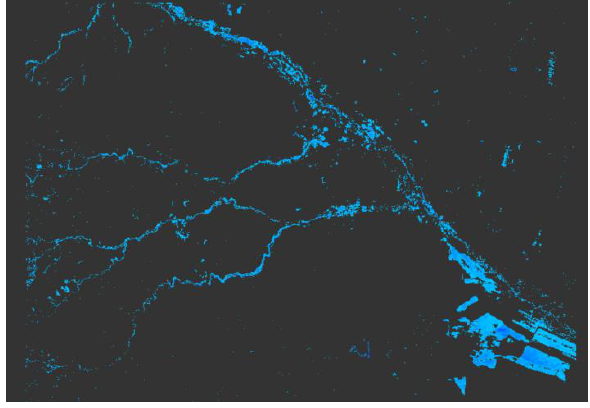
Figure 9. Flooded area according to MSI